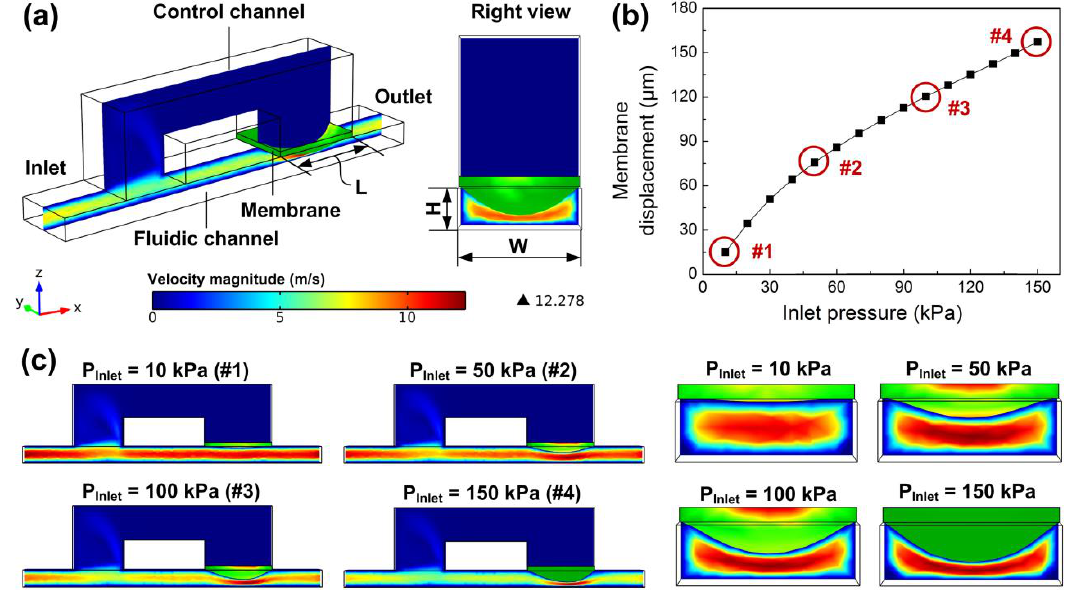
Figure 5. Fluid-Structure Interaction (FSI) model of a flow regulating valve. ( a ) Axonometric and right views of the FSI model, with the color bar representing the velocity magnitude of the liquid domain; ( b ) Membrane displacement versus inlet liquid pressure increasing from 10 kPa to 150 kPa; ( c ) Membrane deformations under different inlet liquid pressures of 10 kPa, 50 kPa, 100 kPa, and 150 kPa.